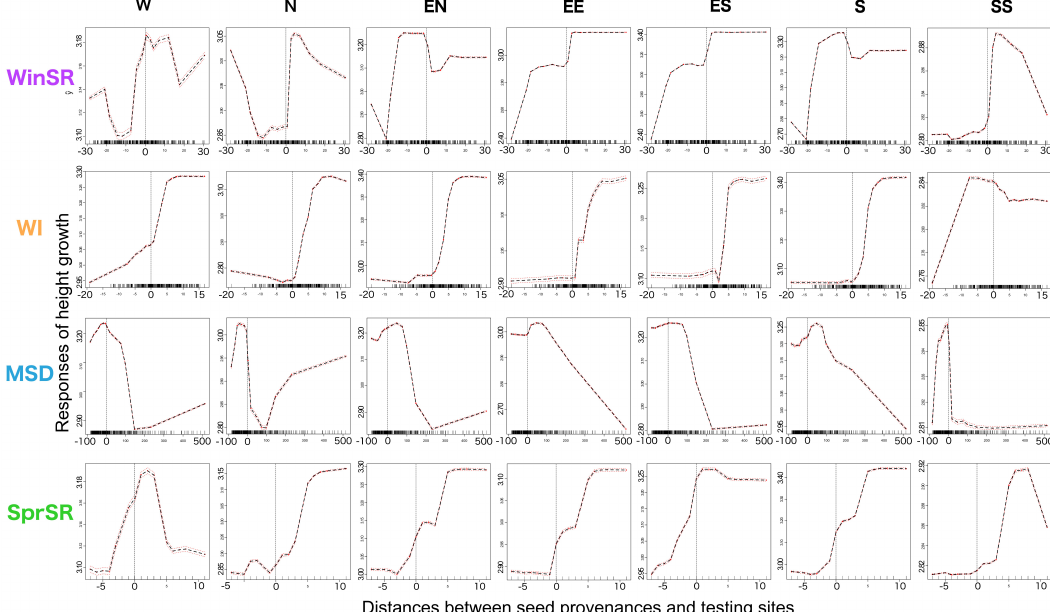
Figure 4. Responses of height growth to important climatic variable distances in each regional group according to multivariate random forests. Dashed black lines indicate expected values, dashed red lines indicate mean confidence intervals (expected values ± 2 × standard errors), and rugs on x-axes indicate data